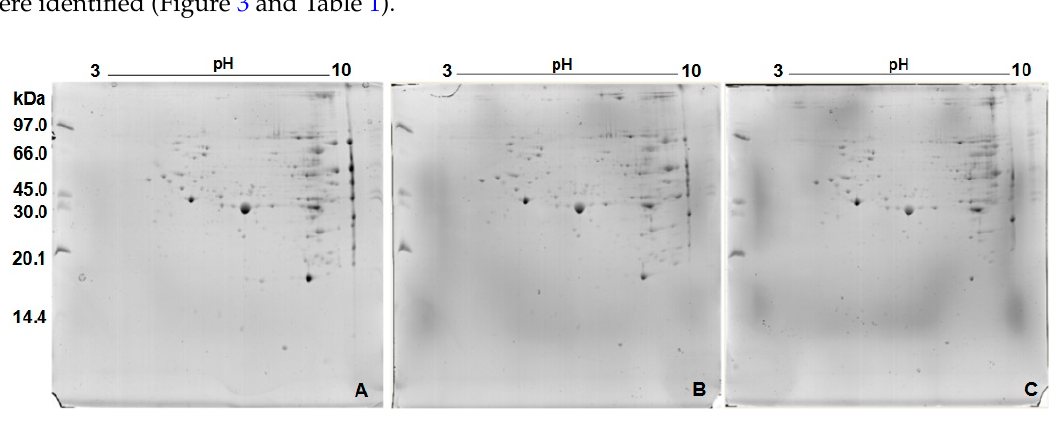
Figure 2. Two-dimensional gels of Neoponera villosa venom: ( A ) Replica 1 (Reference gel); ( B ) Replica 2; and ( C ) Replica 3.